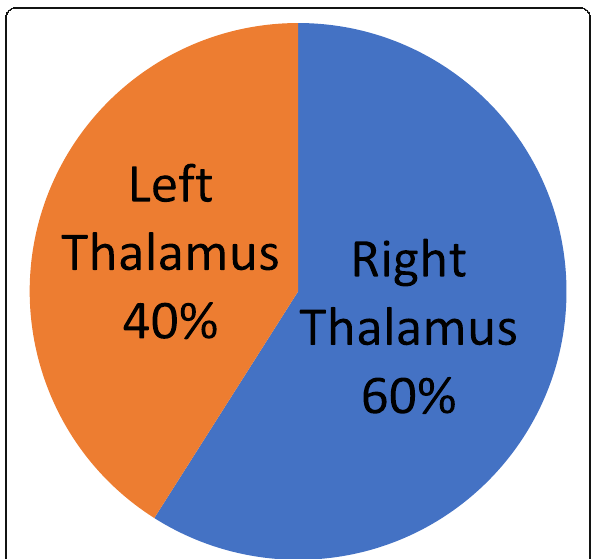
Fig. 1 Pie chart showing percentage distribution of the lesions in the thalamus